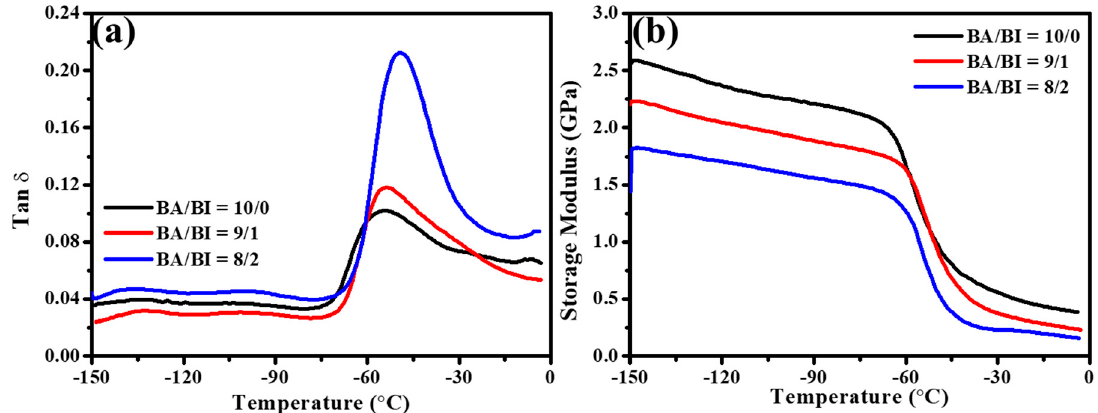
Figure 5. Dynamic mechanical analyzer results for ( a ) Tan δ and ( b ) storage modulus of PBABI copolyesters with a ratio from 10/0 to 8/2.